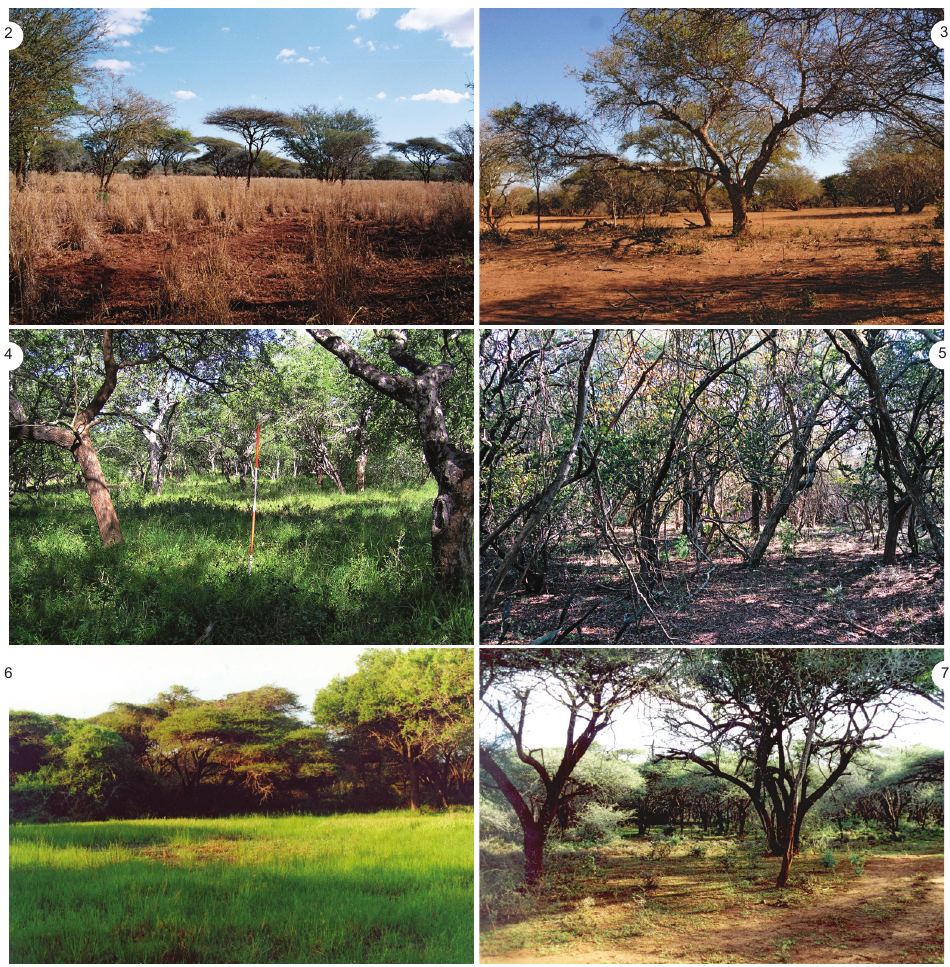
Figs. 2–7. Savanna and associated habitats in Ndumo Game Reserve: 2–3) Acacia tortilis savanna (AS) domi - nated by Acacia tortilis (2) and Albizia spp. (3) trees; 4) Deciduous broadleaf woodland (BW); 5) Sand forest (SF); 6–7) Subtropical bush (SB) consisting of Mahemane thicket (6) and Acacia nigrescens woodland